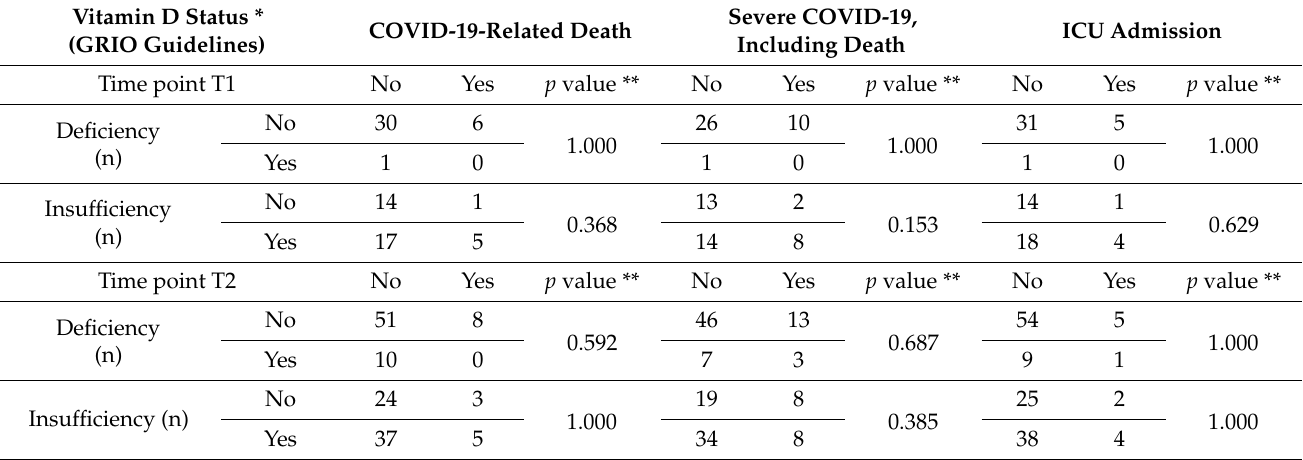
Table 6. Vitamin D status and COVID-19